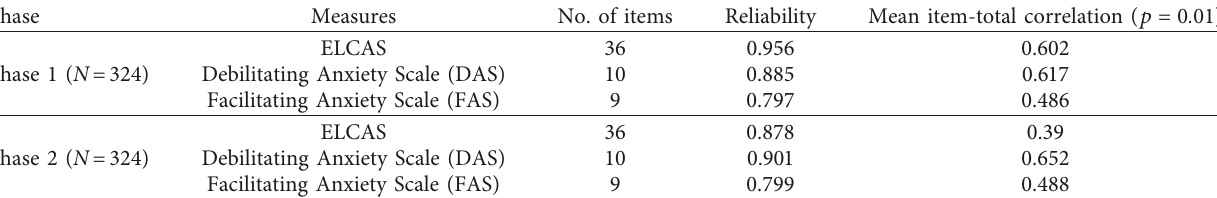
Table 2: Characteristics of instruments.